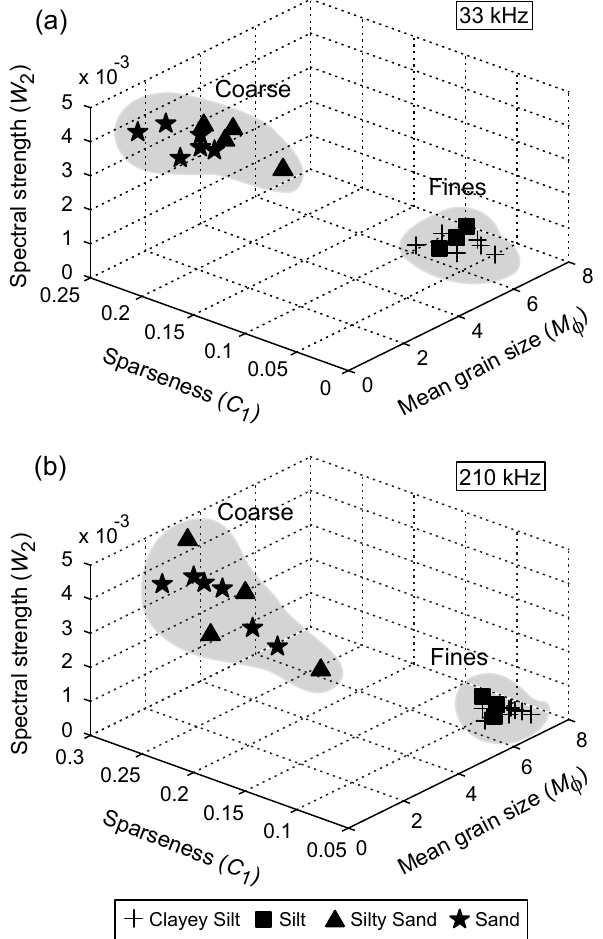
Fig. 8. 3-D scatter diagram showing clustering among M ϕ , C 1 and w 2 at 33 and 210kHz. Regions comprising coarse and fine sedi- ments can be seen clearly